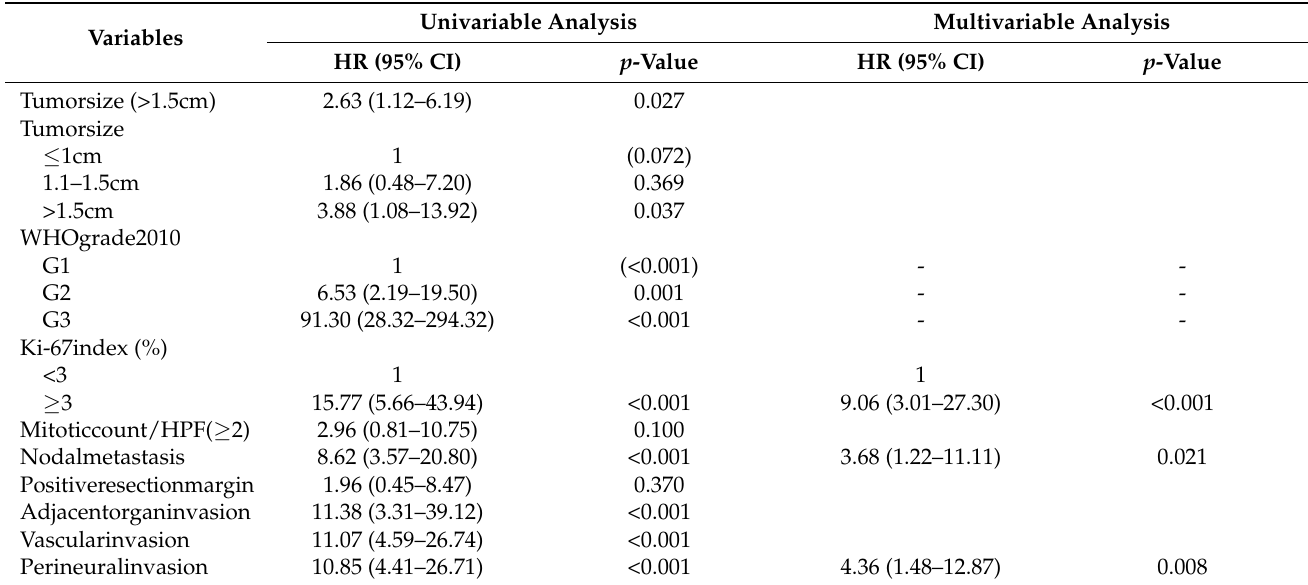
Table 3. Risk factor analysis for recurrence-free